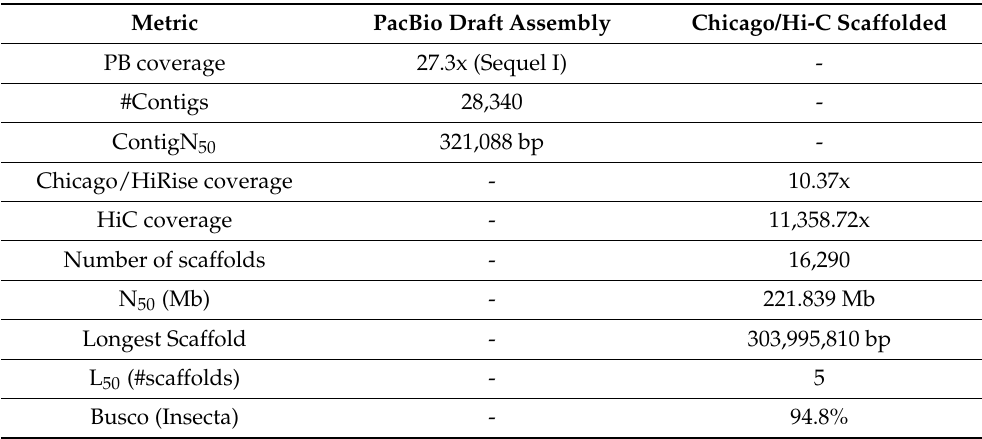
Table 1. Metrics of the A. domesticus genome assembly. Data included the CANU draft assembly from PacBio long read data, and the scaffolded assembly from Chicago and Hi-C long range